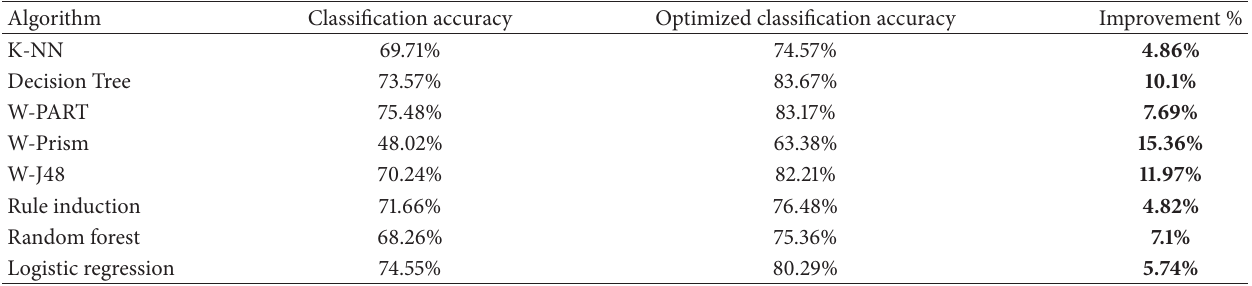
Table10:Resultsofsonardataset:comparisonofoptimizedclassificationaccuracyusingGMCmodelwithsimpleclassificationusingdifferent classifiers.